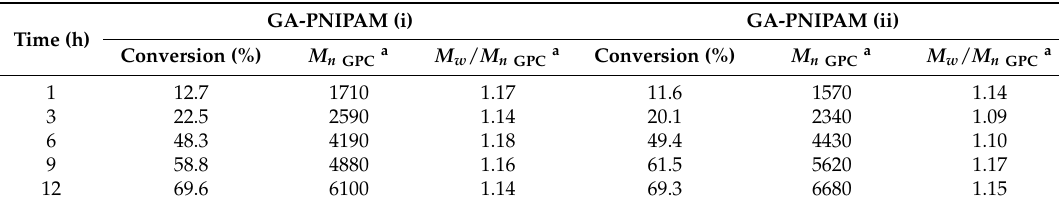
Table 1. Polymerization of GA-PNIPAM (i) and